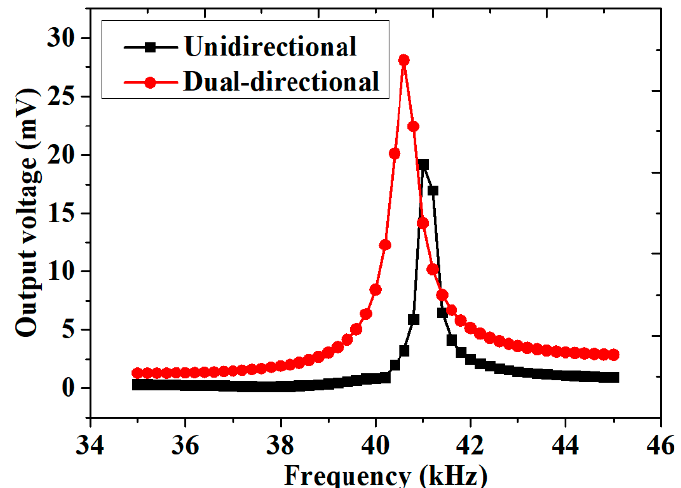
Figure 7. The output voltage for unidirectional and dual-directional coupled resonators.